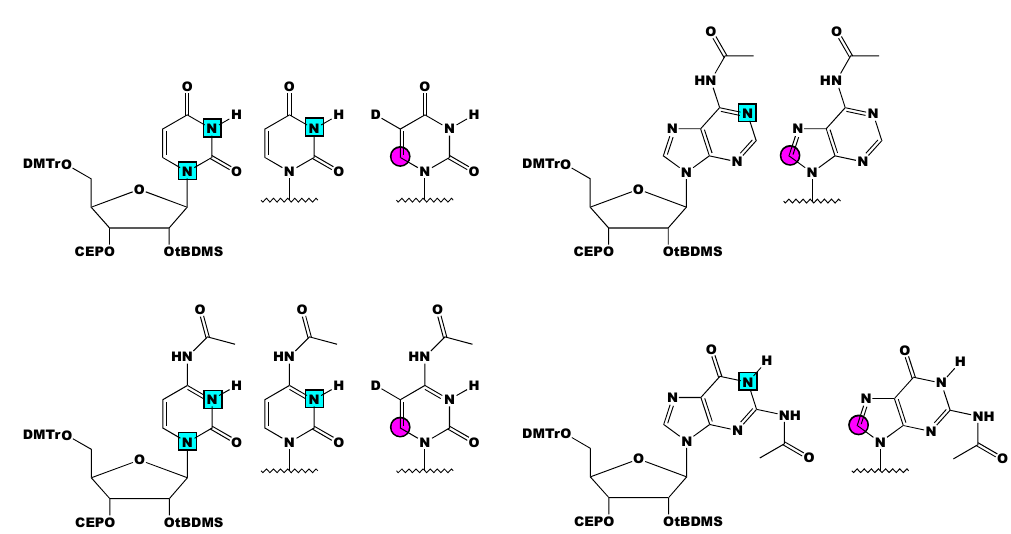
Figure 7. Schematic of all the isotope labeled 2 ′ -O-tBDMS RNA phosphoramidites made commercially available by Silantes. [1,3- 15 N 2 ]-, [3- 15 N]-, and [6- 13 C-5- 2 H]-uridine and [1- 15 N]- and [8- 13 C]-adenosine are shown on the top. [1,3- 15 N 2 ]-, [3- 15 N]-, and [6- 13 C-5- 2 H]-cytidine and [1- 15 N]- and [8- 13 C]-guanosine are shown on the bottom. All phosphoramidites (except uridine) are N -Ac protected. Magenta circles represent 13 C atoms, cyan squares represent 15 N atoms, and D represents 2 H atoms.